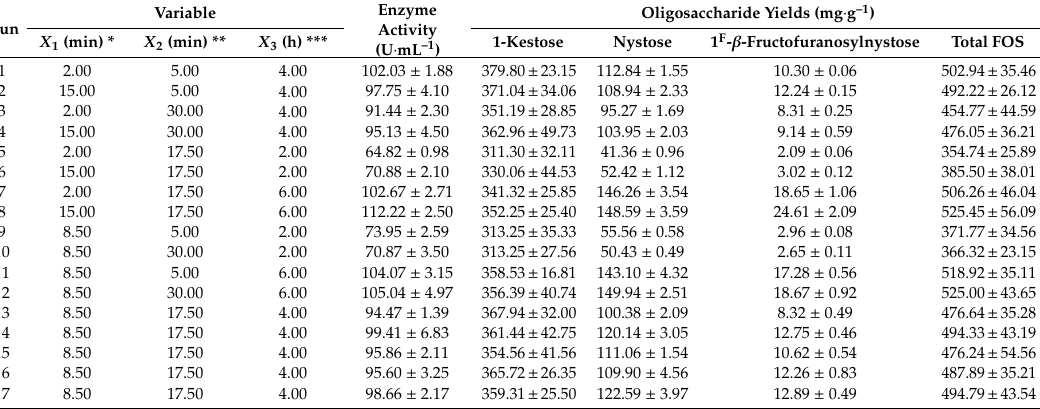
Table 1. The Box-Behnken experimental design and experimental values of enzymatic activity and FOS yields produced from brown